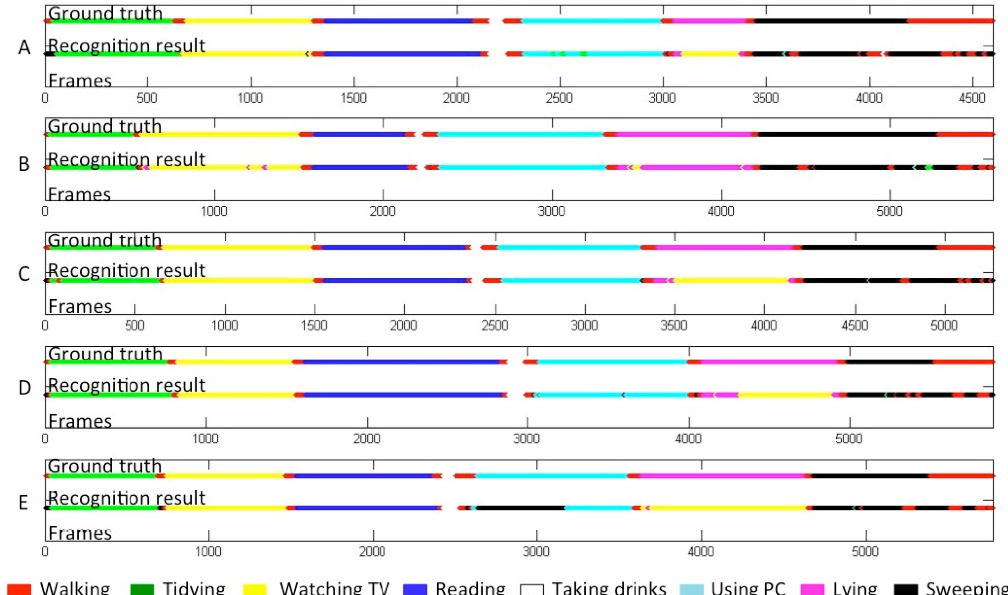
Figure 7. The ground truth and recognition results of five users spending 4–5 minutes in the detection area. Different colors show different